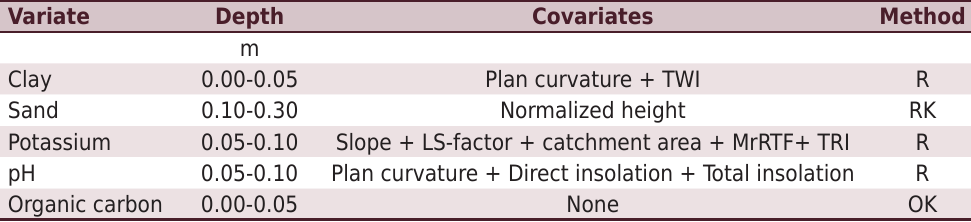
Table 1. Decision rules for selecting the appropriate DSM function [adapted from Ciampalini et al. (2012)] Variate Depth Covariates Method m Clay 0.00-0.05 Plan curvature + TWI R Sand 0.10-0.30 Normalized height RK Potassium 0.05-0.10 Slope + LS-factor + catchment area + MrRTF+ TRI R pH 0.05-0.10 Plan curvature + Direct insolation + Total insolation R Organic carbon 0.00-0.05